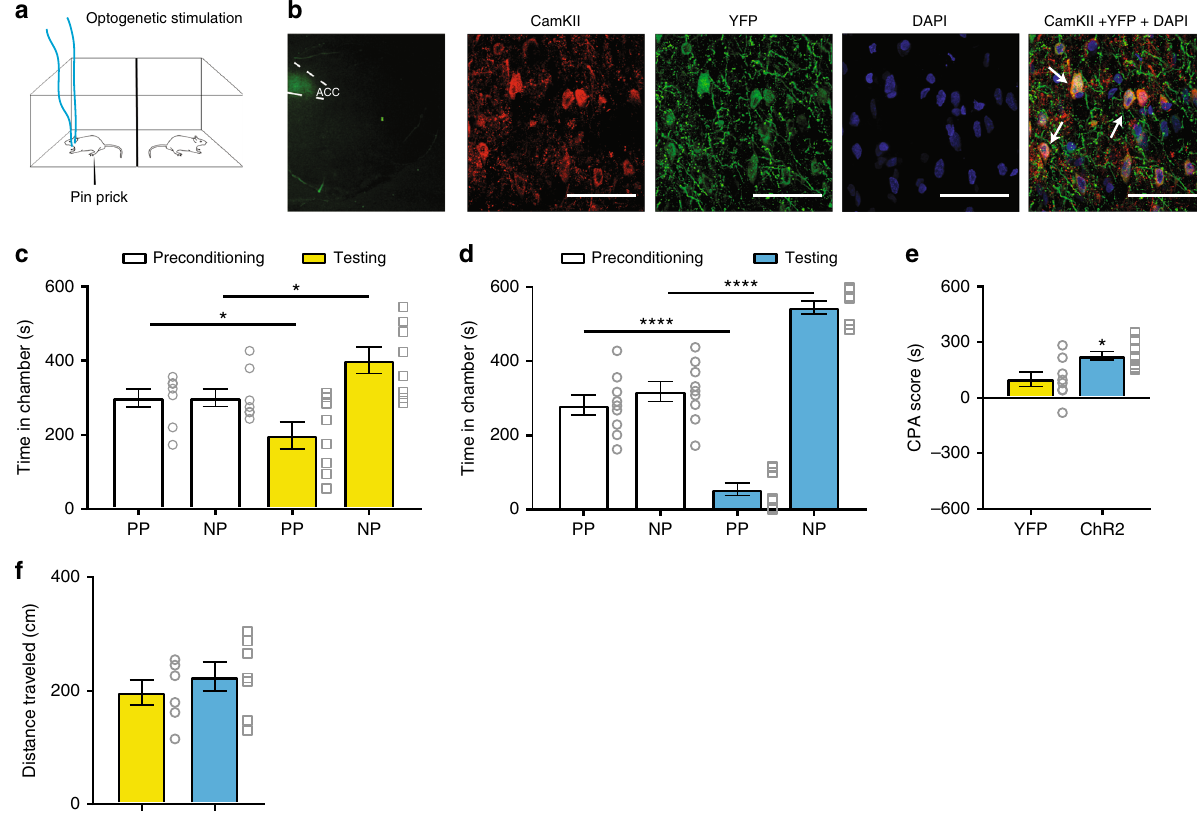
Fig. 6 Ketamine inhibits ACC activities to reduce pain aversion. a Schematic of the CPA assay with optogenetic activation of the ACC in CFA-treated rats. Light stimulation was paired with PP in one chamber during the conditioning phase, and the other chamber was paired with NP. b Expression of YFP-ChR2 in the ACC. From left to right: low magni fi cation (×20) view of ChR2-eYFP in the ACC; high-magni fi cation (×100) view of CaMK II staining, YFP-ChR2 staining, DAPI staining, and Merged images. Arrows point to sample co-stained neurons. c , d ACC activation blocked the anti-aversive effects of ketamine in CFA-treated rats. c CPA test for YFP rats that received CFA and ketamine treatments; n = 8; p = 0.0381, paired Student ’ s t -test. d CPA test for ChR2 rats that received CFA and ketamine treatments; n = 9; p < 0.0001. e The anti-aversive effect of ketamine in CFA rats was eliminated by the activation of ACC, as shown by the increased CPA score in the ChR2 group; n = 8 – 9; p = 0.0133, unpaired Student ’ s t -test. f Activation of the ACC did not alter locomotion; n = 7; p = 0.4348, unpaired Student ’ s t -test. Error bars represent S.E.M. Scale bar equals 50 μ m in b . ∗ p < 0.05; ∗∗∗∗ p <